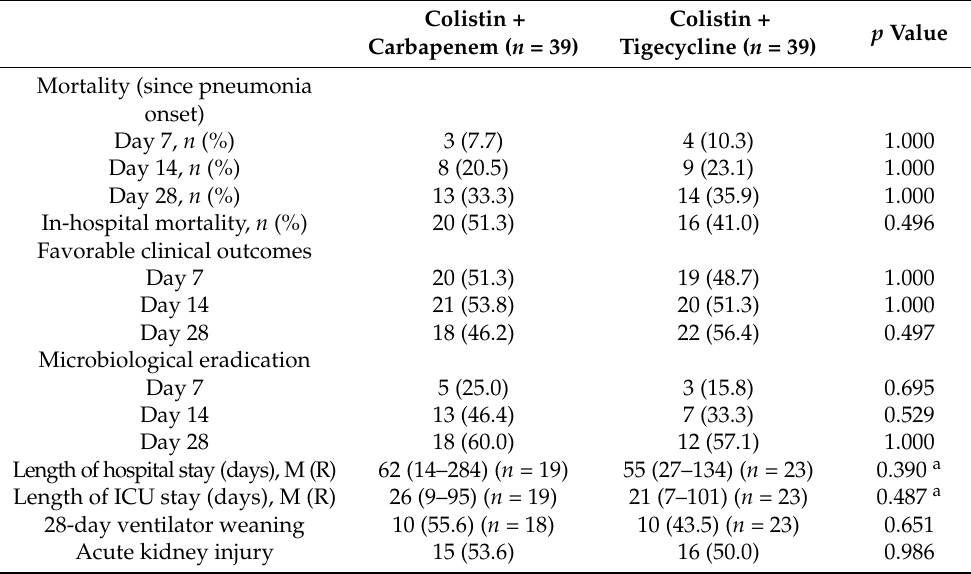
Table 3. Therapeutic efficacy and acute kidney injury in the colistin + carbapenem and colistin + tigecycline groups after propensity score matching.